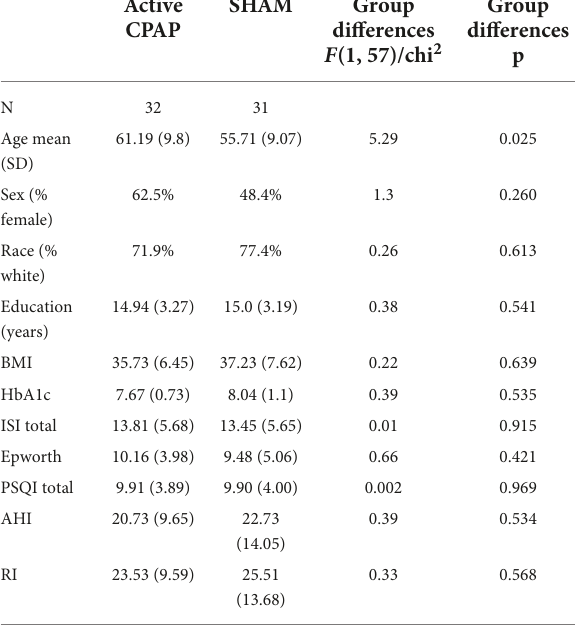
TABLE 1 Demographic and clinical characteristics in participants undergoing active CPAP and participants undergoing SHAM CPAP. Active CPAP